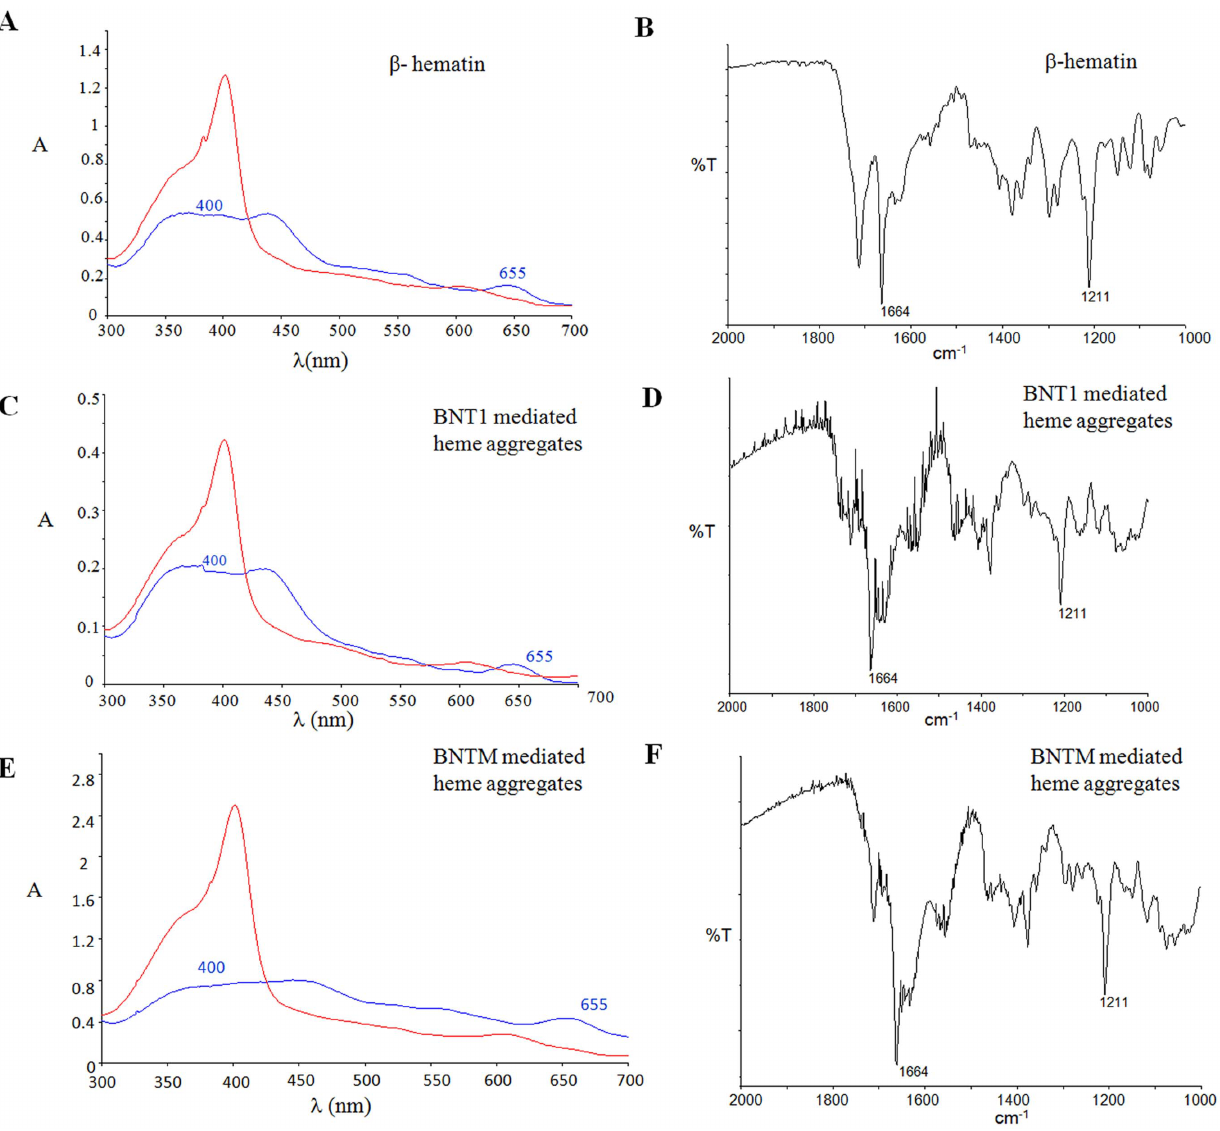
Figure 3. Spectroscopic characterization of bicarbonate stable heme aggregates formed in presence of BNT1/BNTM. Panels A, C and E show UV-visible spectra of b -hematin and BNT1/BNTM mediated bicarbonate stable heme aggregates respectively. These aggregates were incubated overnight in 2.5% aqueous SDS prior to recording spectra (blue line). Note the broad Soret (400 nm) and the weak but characteristic peak at 655 nm. Typical hematin spectra (sharp Soret at 400 nm - red line) were obtained when each suspension was made 0.02 N with respect to NaOH. Panels B, D and F show the FTIR spectra of b -hematin and BNT1/BNTM mediated bicarbonate stable heme aggregates respectively. Peaks at 1664 cm 2 1 and 1210 cm 2 1 in FTIR spectrum of heme aggregates mediated by BNT1 and BNTM confirm their identity as b